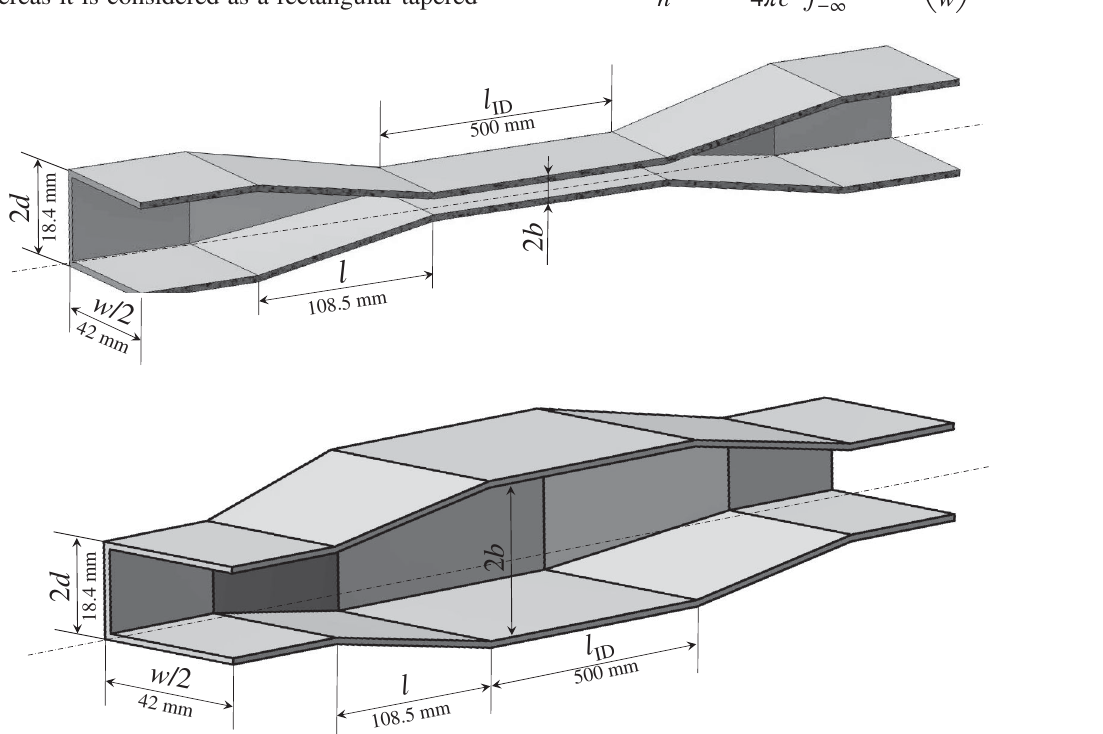
FIG. 2. Simplified model for wakefield simulation: rectangular tapered collimator (upper) and rectangular tapered cavity